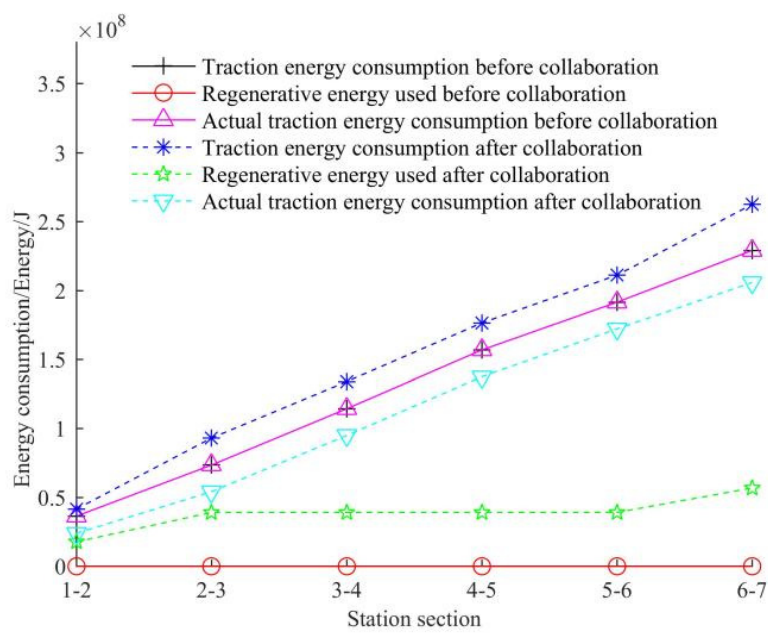
Figure 10. Energy consumption simulation diagram of Train 3. Table 4. Comparison table of the regenerative energy used by the follower trains before and after the cooperation.